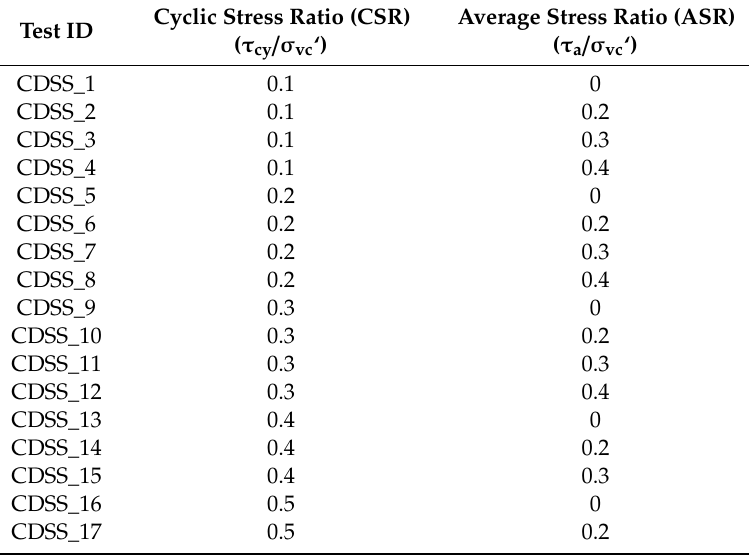
Table 2. Summary of cyclic direct simple shear (CDSS) tests with corresponding cyclic stress ratio (CSR) and average stress ratio (ASR) values.